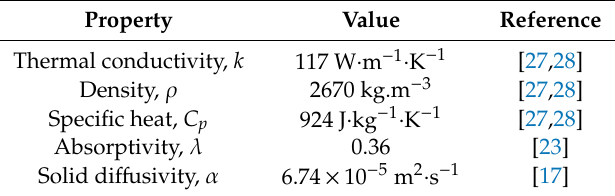
Table 4. Room-temperature thermal properties of aluminum alloy 5456 used in the analytical